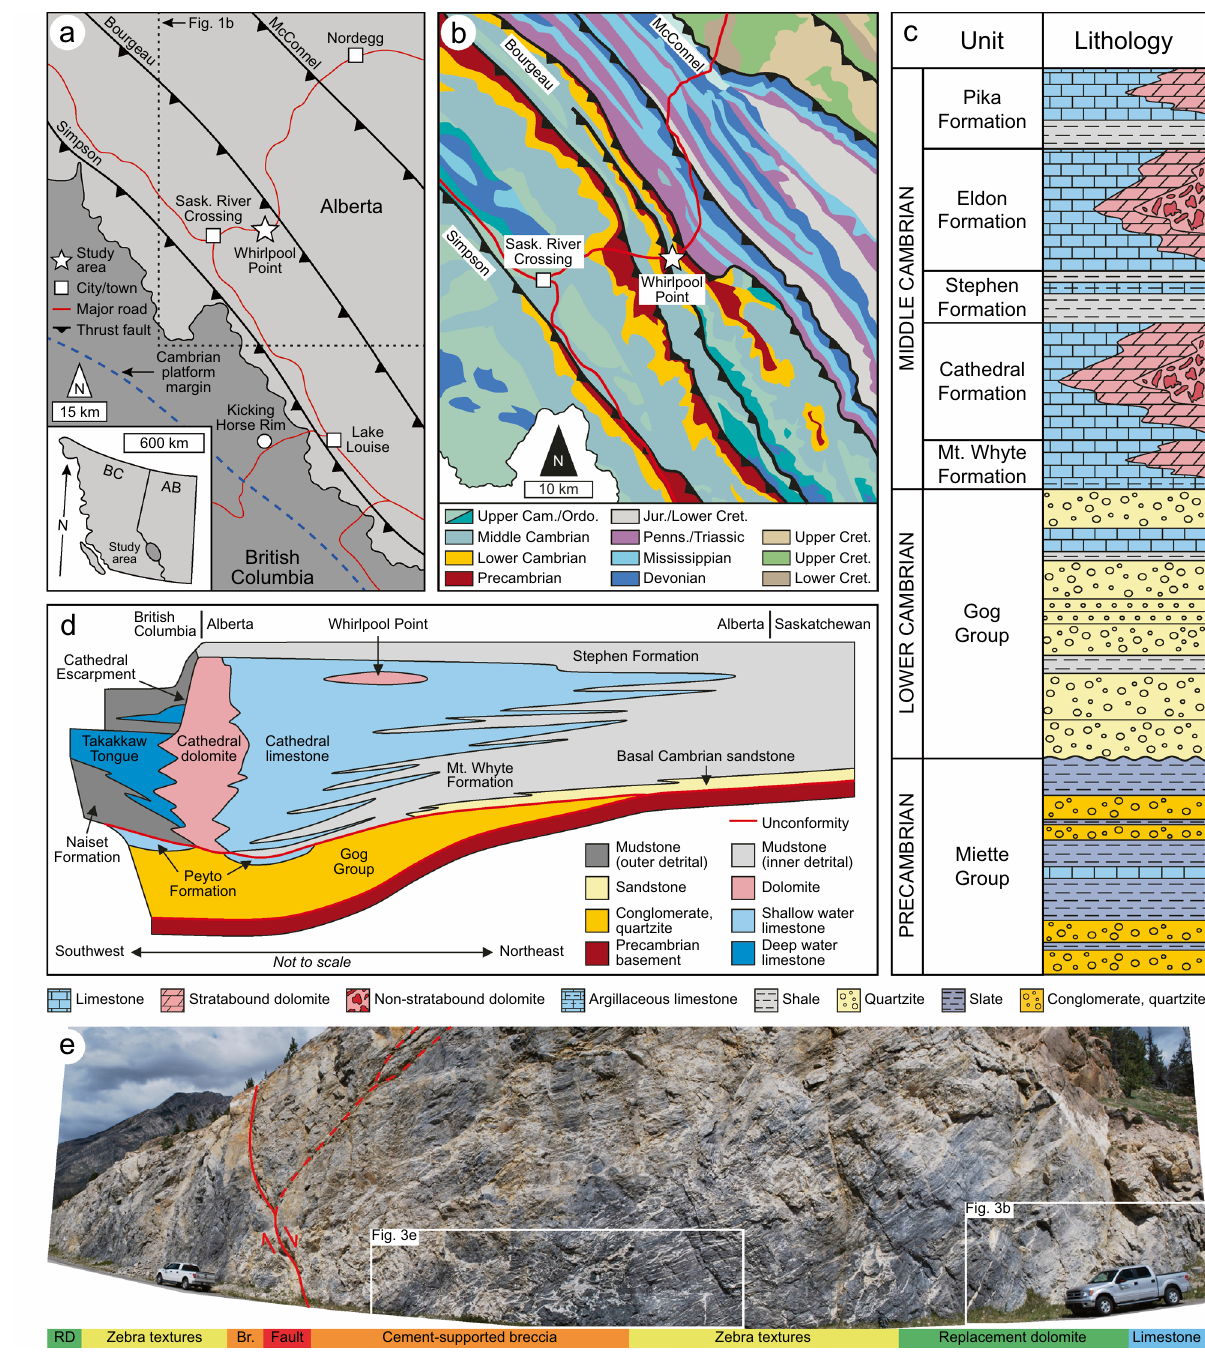
Figure 1. ( a ) Location of the study area in Alberta, Canada showing the major thrust faults and the Cambrian platform margin (modified from Stacey et al. 26 ; based on Vandeginste et al. 37 ). ( b ) Geological map of the study area (modified from Stacey et al. 26 ; based on the Alberta Geological Survey Interactive Minerals Map: https:// ags. aer. ca/ publi cation/ iam- 001). ( c ) Stratigraphy of the southern Rocky Mountains (drafted by Dr. J. Stacey, based on Aitken 32,34 ). ( d ) Schematic cross-section of the Cathedral carbonate platform in the southern Rocky Mountains (modified from Stacey et al. 26 ; based on Aitken 32,34 ). ( e ) Photomosaic of the Cathedral Formation at Whirlpool Point showing the diagenetic facies in relation to a normal-to-transtensional fault. Photographs provided by Dr. C. Hollis. Note that the scale changes throughout the photomosaic. Vehicle = 5 m in